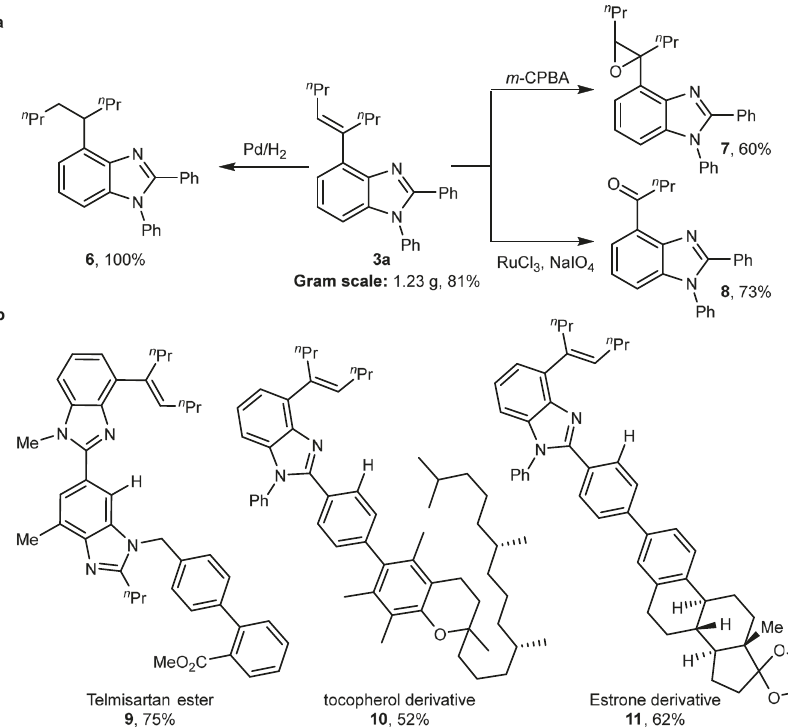
Fig. 5 Synthetic utility. a Gram-scale reaction and product transformations. b Late-stage selective β -C − H bond alkenylation of bioactive molecules such as Telmisartan ester, tocopherol derivative and estrone derivative. n Pr = n -propyl. m -CPBA = m -chloro perbenzoic